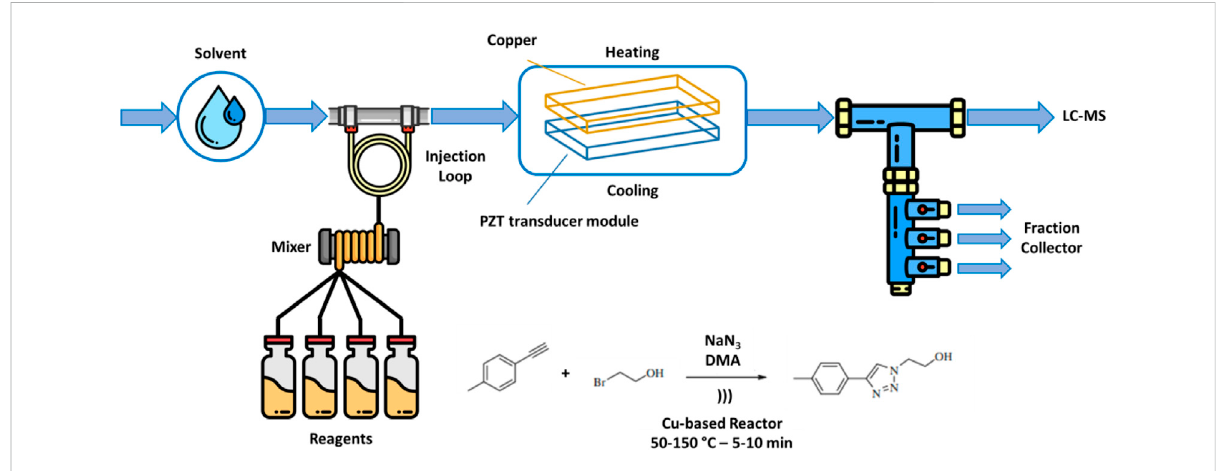
FIGURE 1 Reaction set-up: fl ow set-up and Autochem ’ s PZT transducer; reaction